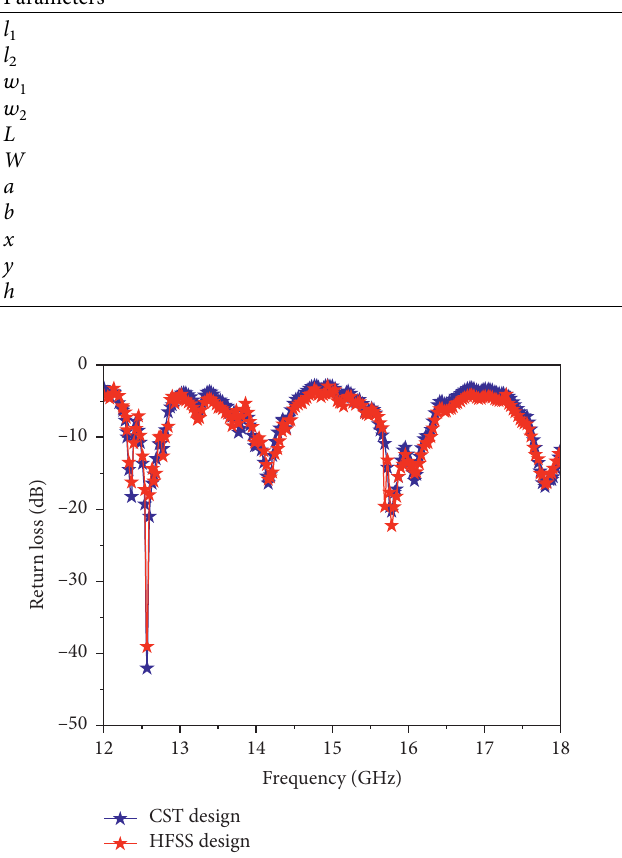
Figure 3: Return loss of the proposed antenna recorded from two different tools.